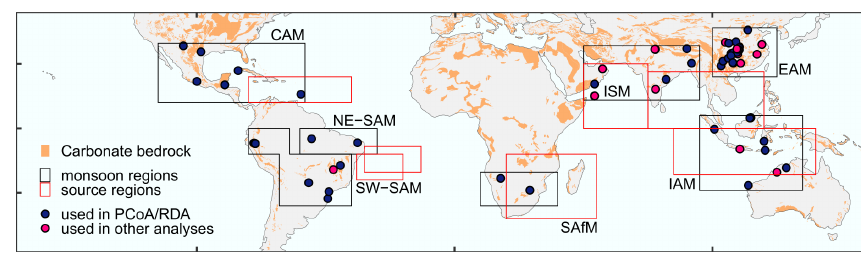
Figure 1. Spatial distribution of speleothem records used is this study. Colours indicate the sites used in principal coordinates analysis (PCoA) and redundancy analysis (RDA) to separate monsoon regions, and sites not used in PCoA and RDA but used in subsequent analyses. The individual regional monsoons are shown by boxes: CAM denotes the Central American monsoon (latitude from 10 to 33 ◦ , longitude from − 115 to − 58 ◦ ), SW-SAM denotes the southwestern South American monsoon (latitude from − 10 to 0 ◦ , longitude from − 80 to − 64 ◦ ; latitude from − 30 to − 10 ◦ , longitude − 68 to − 40 ◦ ), NE-SAM denotes the northeastern South American monsoon (latitude from − 10 to 0 ◦ , longitude: − 60 to − 30 ◦ ), SAfM denotes the southern African monsoon (latitude from − 30 to − 17 ◦ , longitude from 10 to 40 ◦ ), ISM denotes the Indian summer monsoon (latitude from 11 to 32 ◦ , longitude from 50 to 95 ◦ ), EAM denotes the East Asian monsoon (latitude from 20 to 39 ◦ , longitude from 100 to 125 ◦ ) and IAM denotes the Indonesian–Australian monsoon (latitude from − 24 to 5 ◦ , longitude from 95 to 135 ◦ ). Source region limits used in the multiple linear regression analysis are also shown. The background carbonate lithology is from the WOrld Karst Aquifer Mapping (WOKAM) project (Goldschneider et al.,